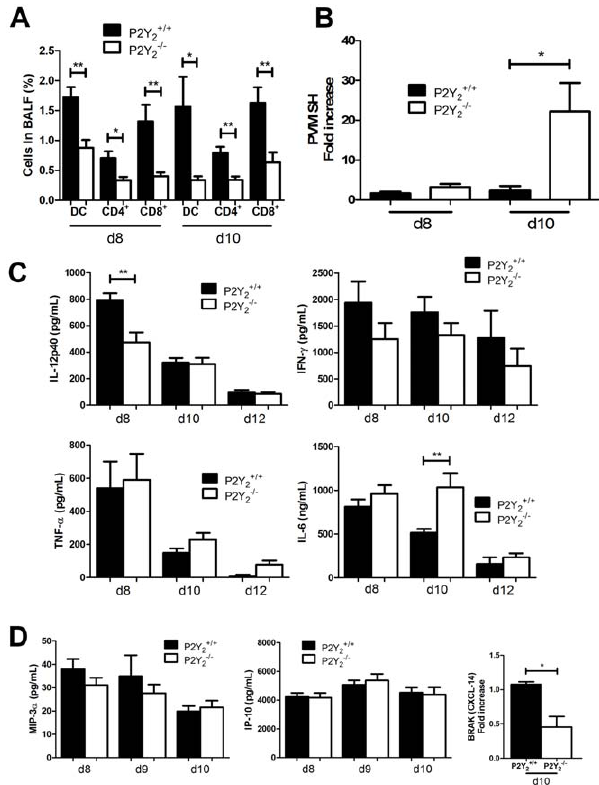
Figure 4. Defective infiltration of DCs, CD4 + T cells and CD8 + T cells in the lungs of PVM-infected P2Y 2 -deficient mice. A. The percentage of DCs (MHC II + CD11c + CD11b + ), CD4 + T cells and CD8 + T cells were determined by flow cytometry analysis in BALFs of P2Y 2 + / + and P2Y 2 2 / 2 mice at day 8 and days 10 (d8 and d10) post-infection (N=5). B. Analysis of viral titer in P2Y 2 + / + and P2Y 2 2 / 2 lungs after infection with PVM. PVM viral titer was quantified by quantitative PCR in lung homogenates of P2Y 2 + / + and P2Y 2 2 / 2 mice 8 or 10 days post- infection. Data were normalized to the viral titer obtained for P2Y 2 + / + lungs at d8. C. IL-12, IFN- c , TNF- a and IL-6 levels were determined by ELISA in the BALFs of PVM-infected P2Y 2 + / + and P2Y 2 2 / 2 mice (N=11). D. The level of DC recruiters was determined by ELISA (MIP-3 a , IP-10) or qPCR (BRAK) in the BALFs of PVM-infected P2Y 2 + / + and P2Y 2 2 / 2 mice